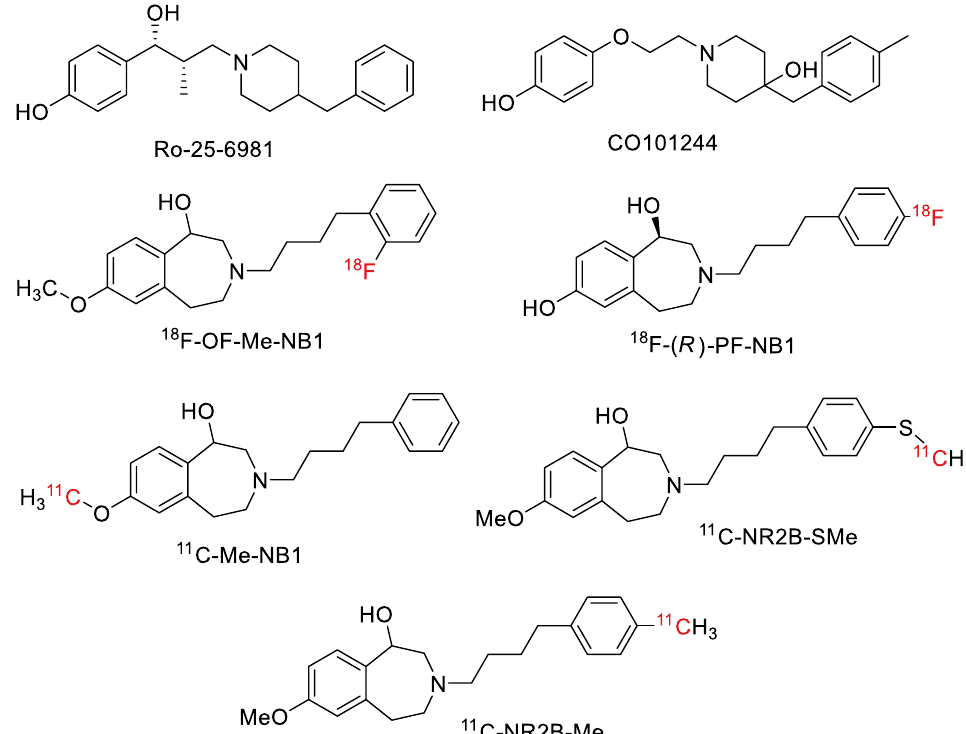
Fig. 1 Structures of GluN2B ligands and candidate GluN2B